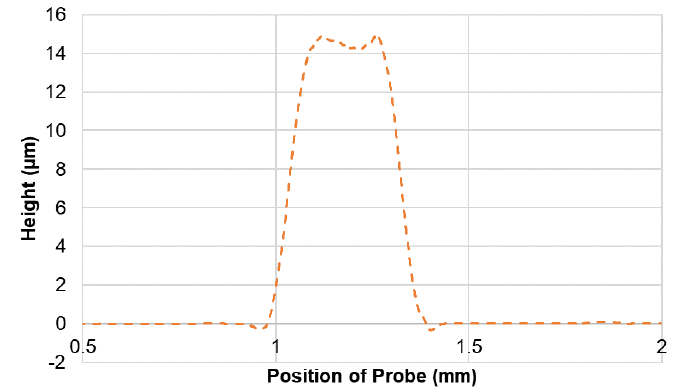
Figure 5. Profile obtained for thickness of single finger of inkjet printing-based (IDE) sensor measured using a stylus profiler.